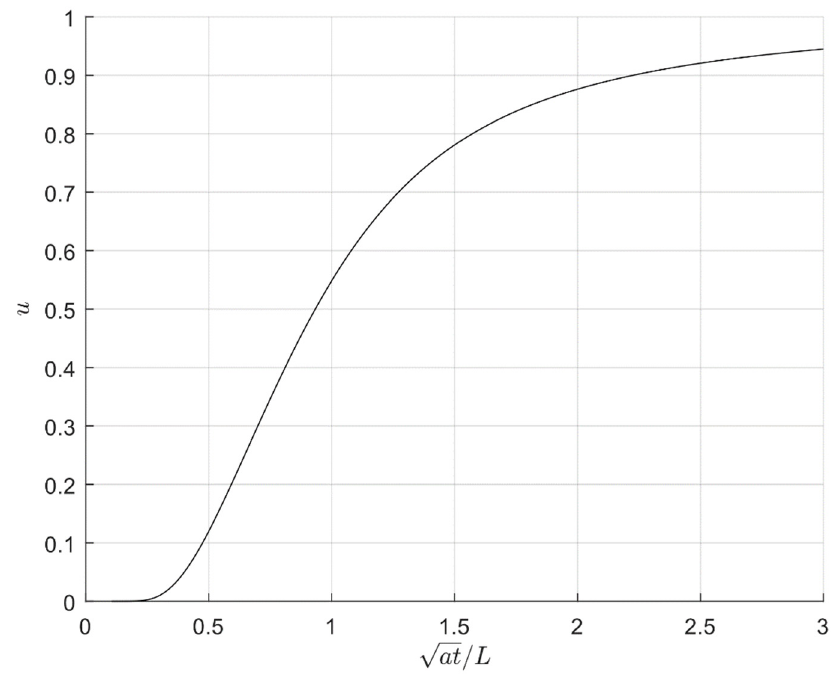
Figure 3. Non-dimensional parameter, u , at the sensor for length L of the rod; the dimensional length √ at √(cid:3028)(cid:3047) is used. L (cid:3013)